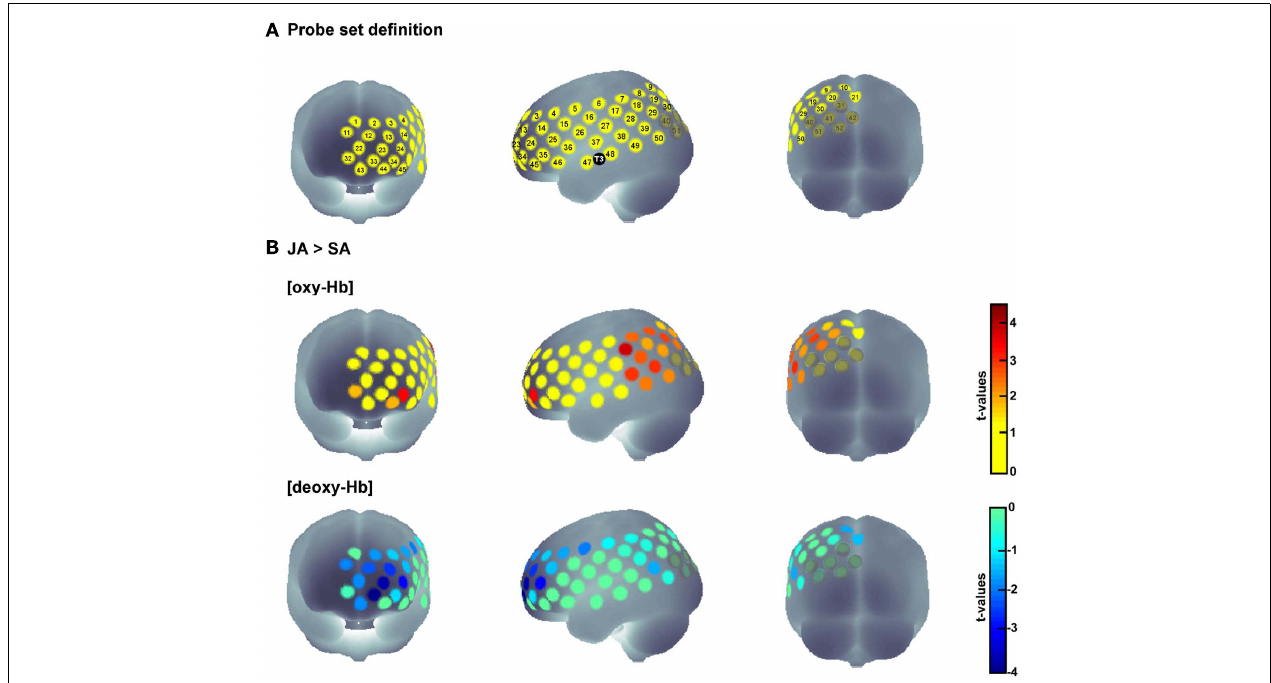
FIGURE 2 | Probe set definition (A) and t -plots for the contrast JA > SA for [oxy-Hb] and [deoxy-Hb] separately (B). Gray shaded channels denote the channels excluded from interpretation for methodological reasons (see Section “Results”). and [deoxy-Hb] by subtracting the baseline from the active peri- ods for each channel and condition. These relative data sets were further analyzed using one-tailed t -tests for paired samples. To depict the hemodynamic response, positive t- values were assigned to an increase in the chromophores and negative t- values were assigned to a decrease in the